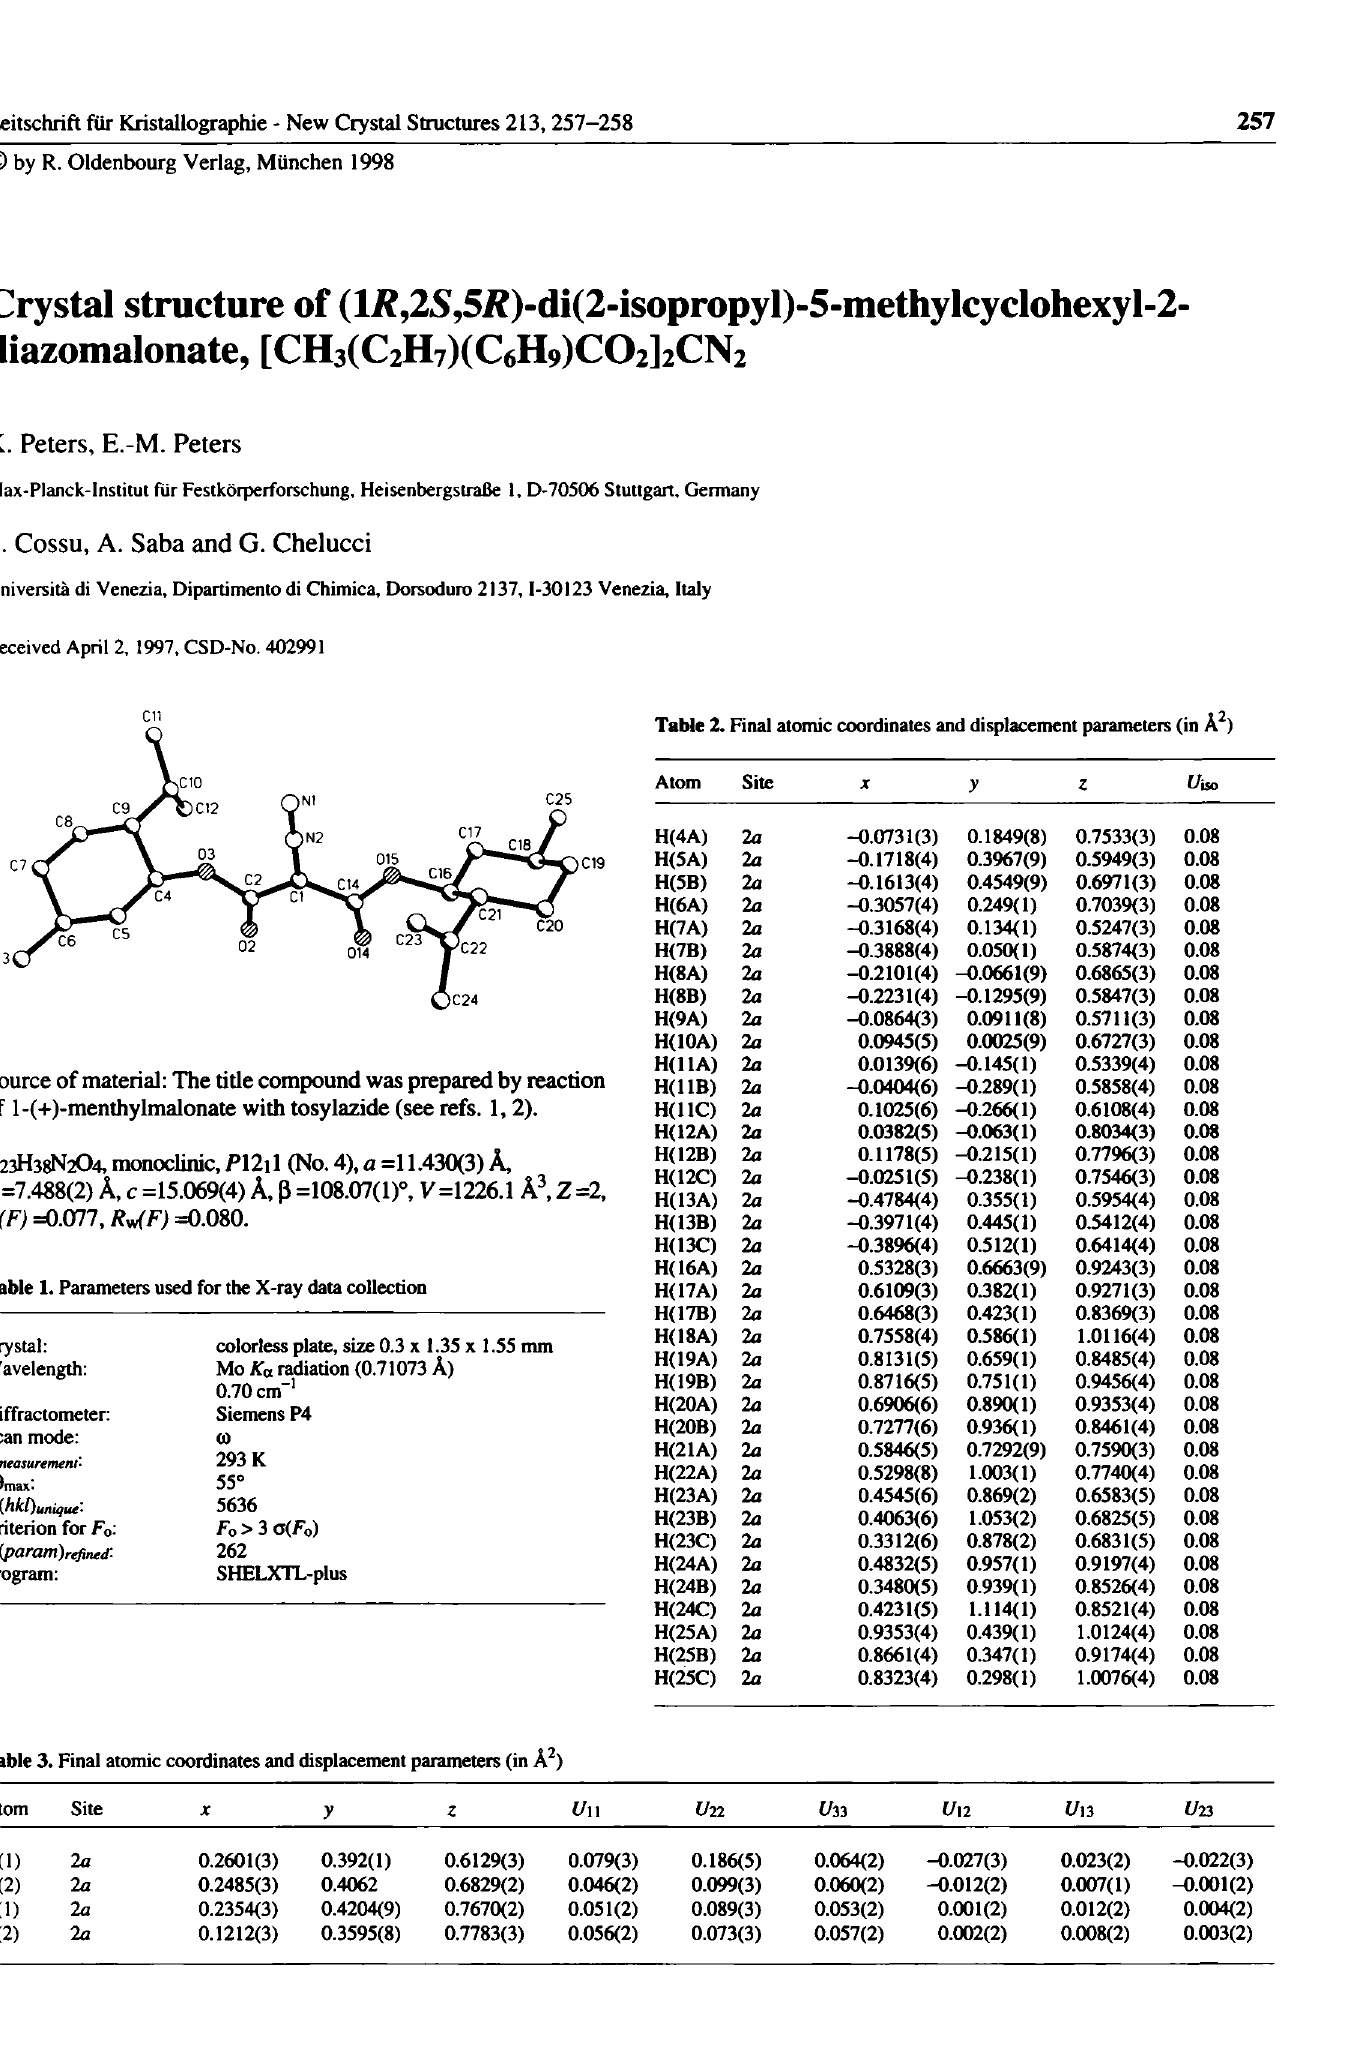
Table 3. Final atomic coordinates and displacement parameters (in